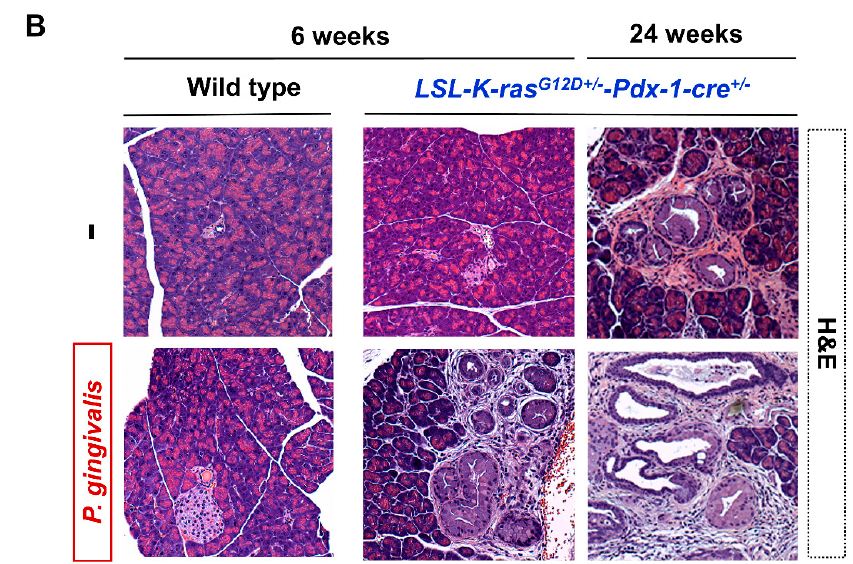
Figure 2. ( A ) Schematic diagram illustrating the time course of intraoral inoculation of P. gingivalis in wild type and KC mice. ( B ) Representative H and E staining images of mouse pancreas in indicated ages of wild type and KC mice either sham-operated or oral inoculation with P. gingivalis . Six-week-old KC mice treated with P. gingivalis significantly developed PanIN lesions at 10 weeks old, and non-treated 6-week-old KC mice developed few PanIN lesions. More severe of lesions found in pancreas of 24-week-old KC mice oral inoculation with P. gingivalis . Exposure to P. gingivalis significantly accelerated the progression of PanIN lesions. PanIN, pancreatic intraepithelial neoplasia.